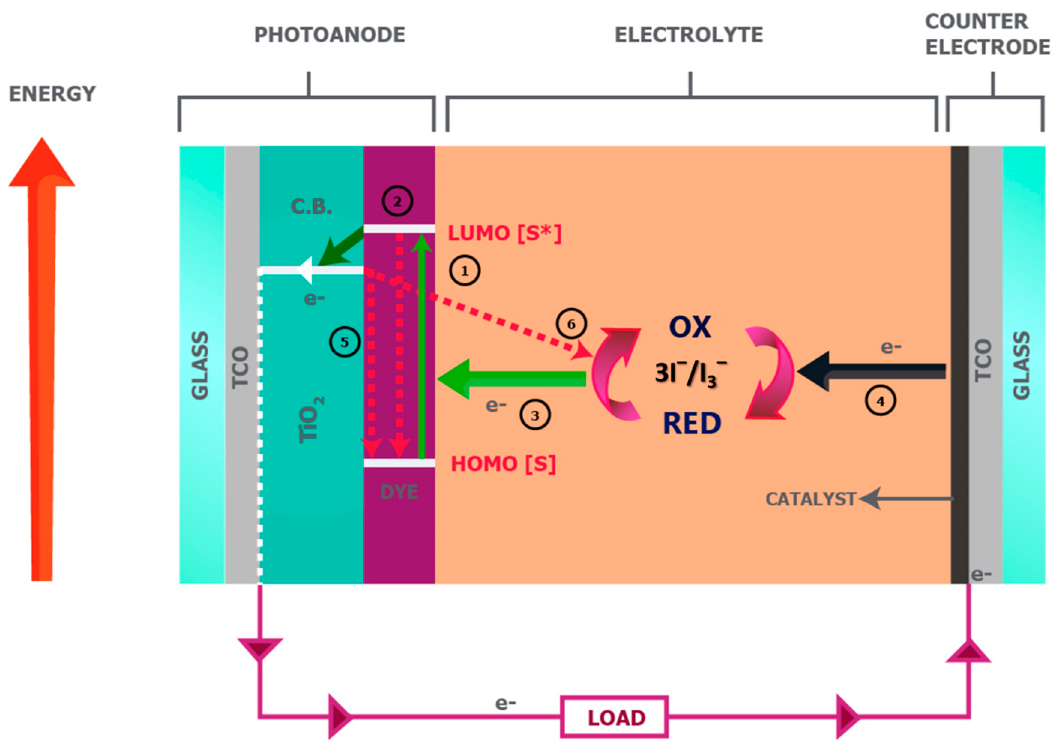
Figure 2. The operating mechanism of a typical dye-sensitized solar cell with iodine electrolyte (employing I − / I 3 − ) redox couple) as an example. 1: Excitation of the dye. 2: Injection of excited electron into the conduction band of the TiO 2 semiconductor. 3: Regeneration of the dye takes place as a result of electrons accepted from the reduced state of the redox mediator, which in turn becomes oxidized itself in the process. 4: Regeneration of the electrolyte by accepting electrons from the counter electrode and returning to (RE) state [2,38].